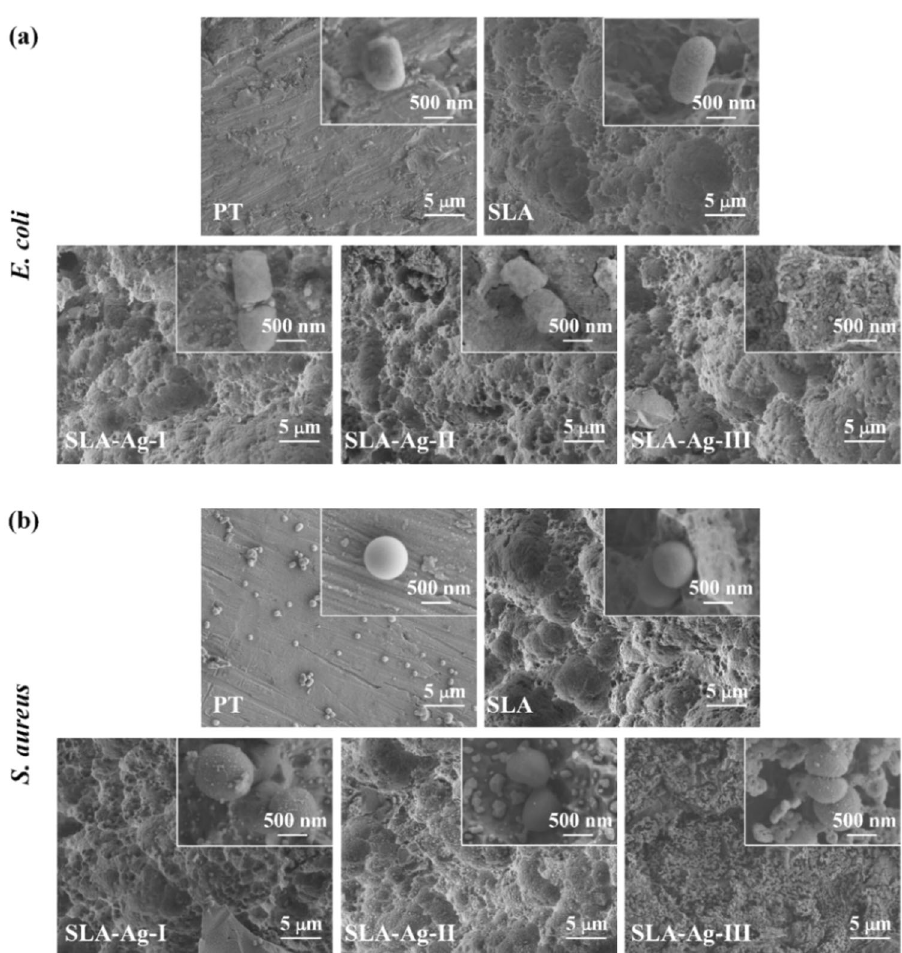
Fig. 5 SEM images showing the E. coli ( a ) and S. aureus ( b ) cultures on various